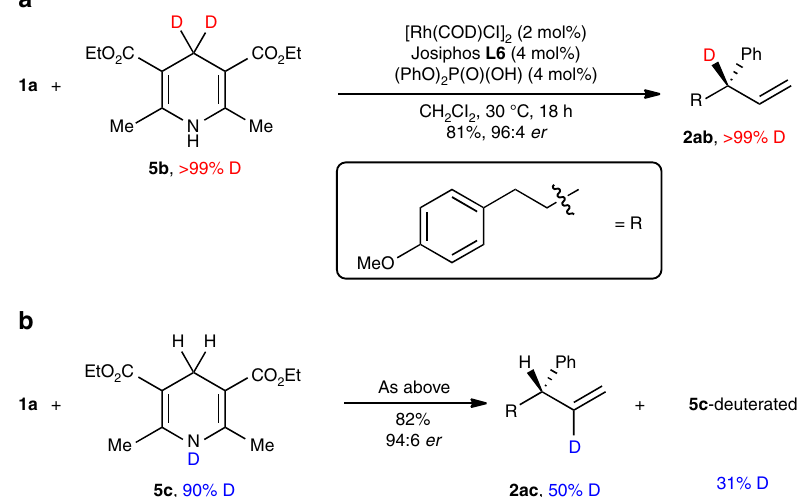
Fig. 5 Deuterium-labelling studies. a Treatment of allene 1a with deuterated Hantzsch ester 5b afforded deuteration in the allylic position. b Analogous experiment with 5c gave deuteration in the vinylic position